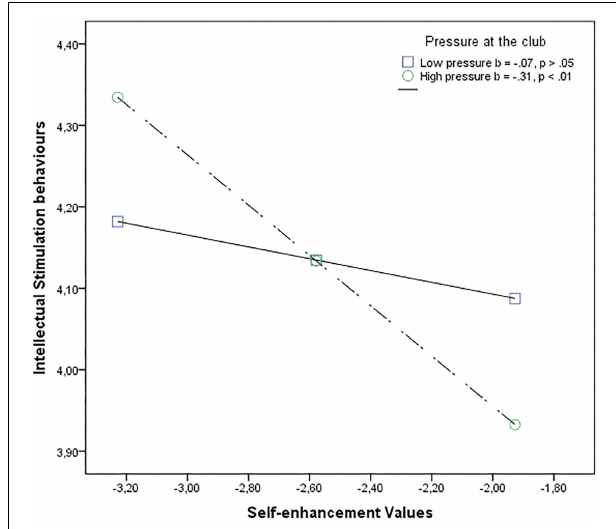
FIGURE 3 | Associations between the self-enhancement values and the intellectual stimulation behaviors as a function of perception of pressure at the